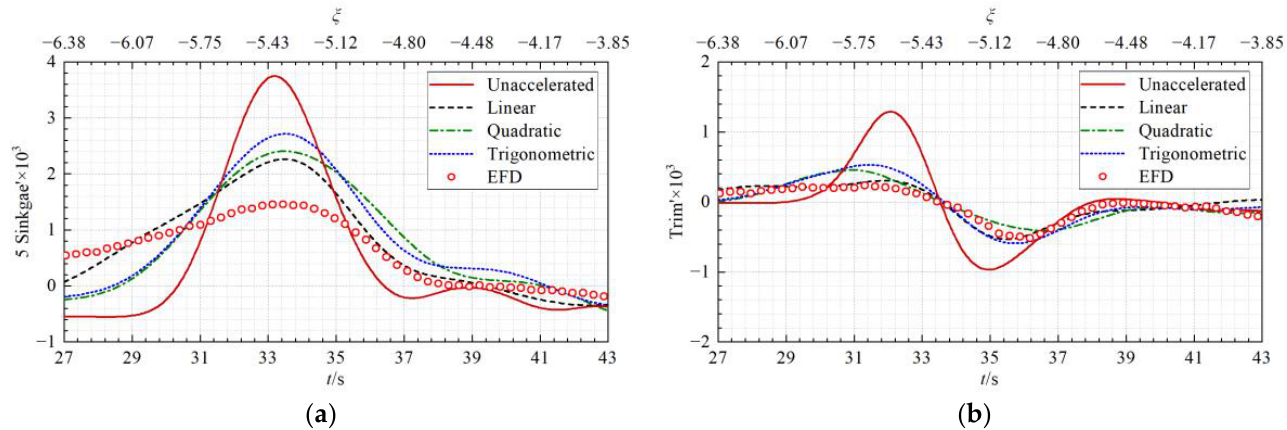
Figure 10. Time histories of attitudes of the moored ship under the impacts of the solitary wave system. ( a ) Sinkage’, ( b ) Trim’.